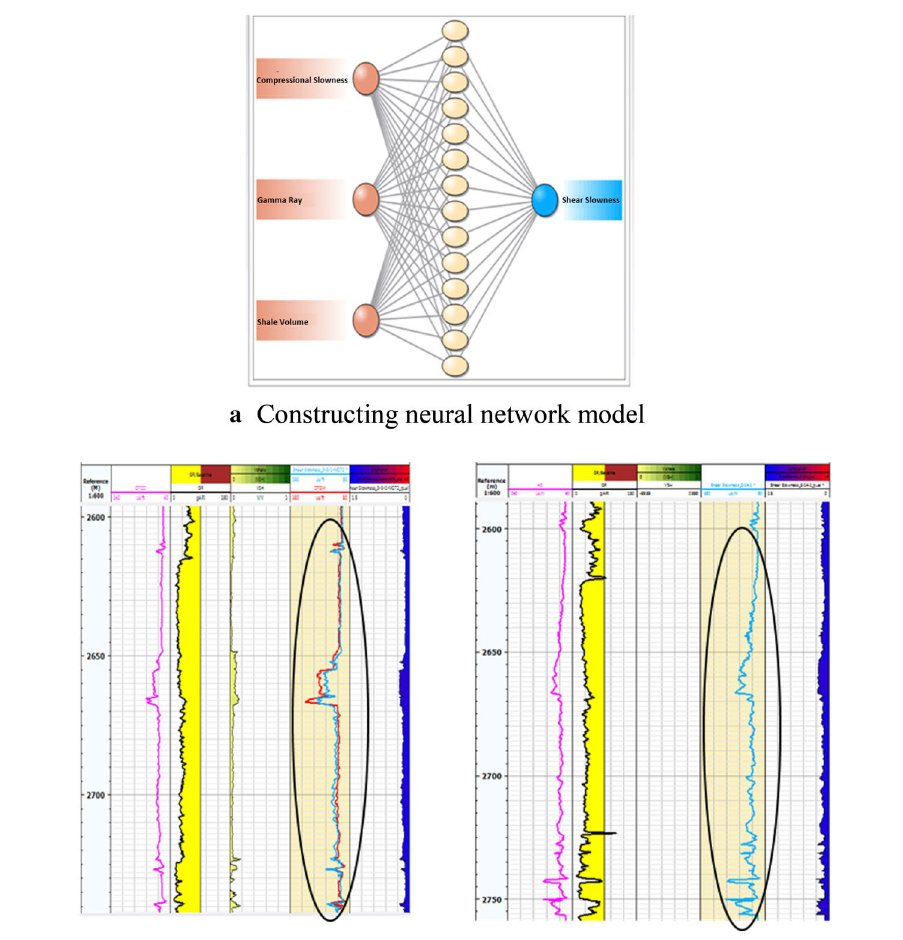
Fig. 4 Shear wave prediction based on a neural network